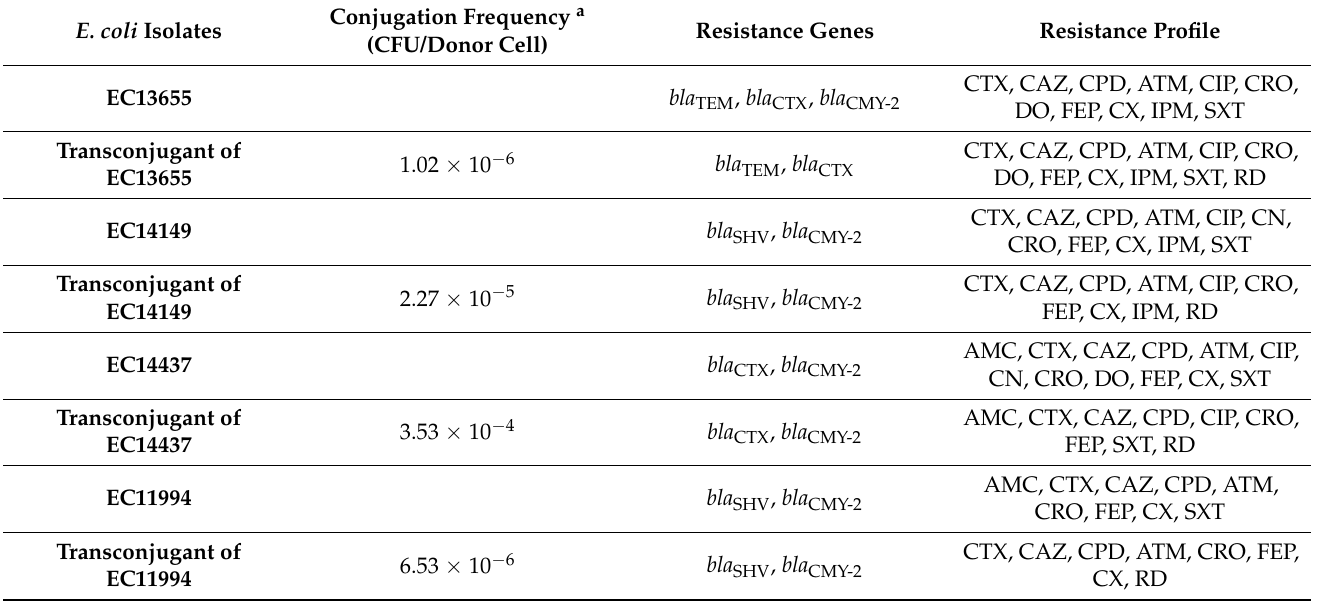
Table 1. Antimicrobial-resistance profile of bla ESBL - and bla CMY-2 -producing E. coli clinical isolates and their